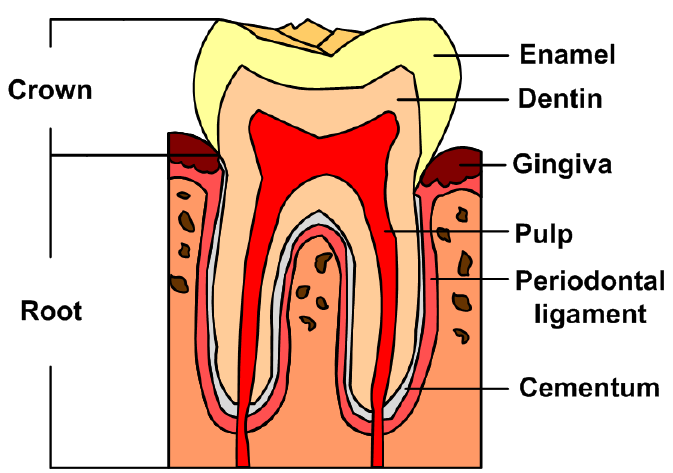
Figure 3. Schematic diagram of a tooth